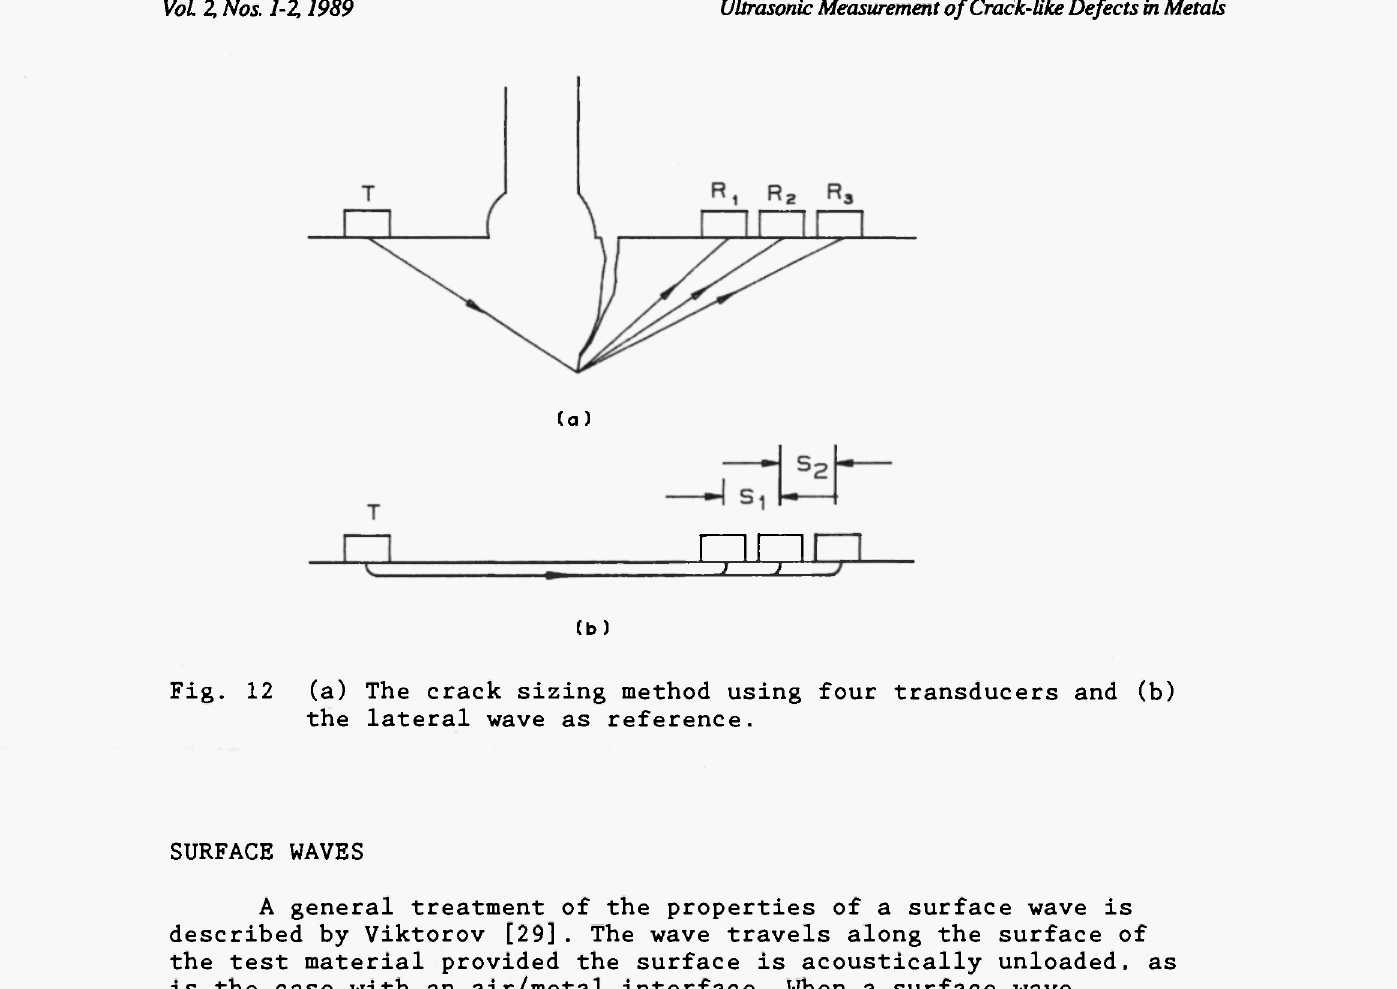
Fig. 12 (a) The crack sizing method using four transducers and (b) the lateral wave as reference.